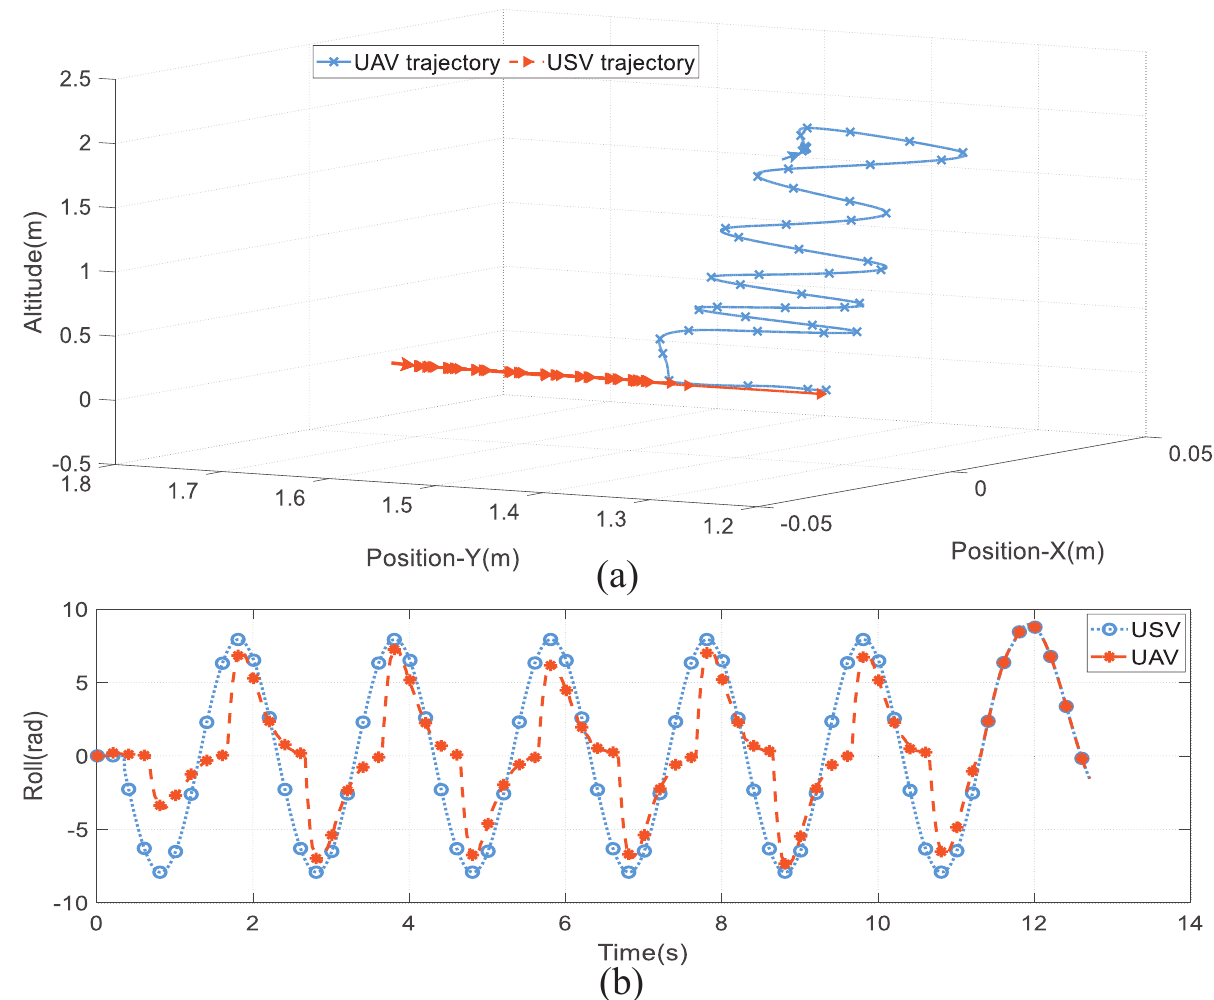
Figure 13. ( a ) USV roll motion − UAV–USV 3D trajectories; ( b ) the variation of UAV–USV roll